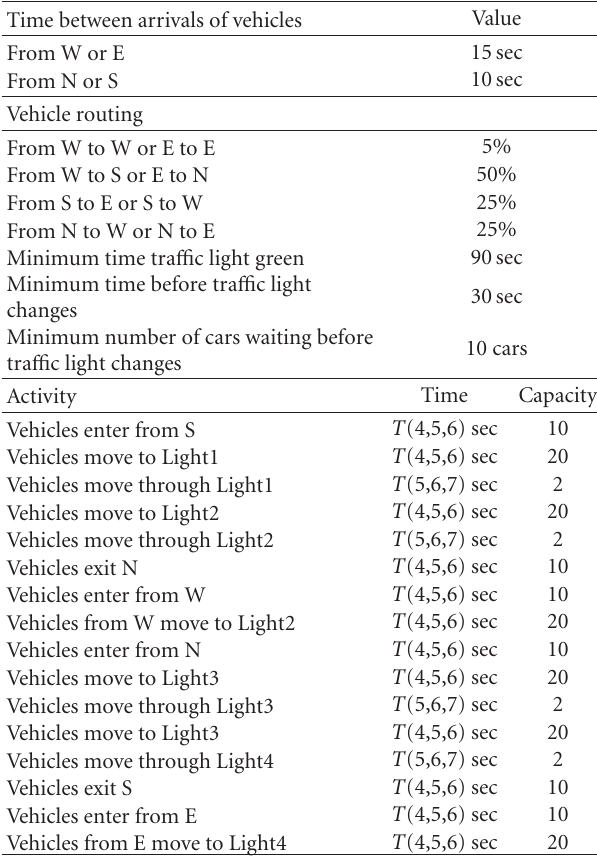
Table 1: Input data for Baseline